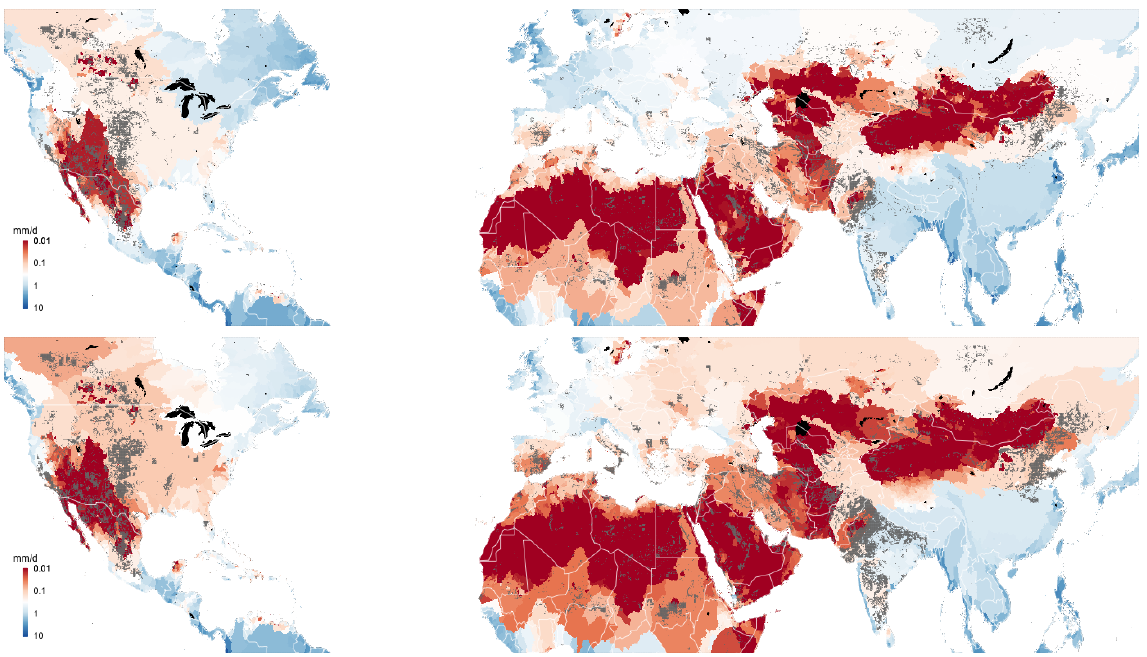
Figure 9. Global limits to stable groundwater withdrawal rate. Top: limit to physically stable groundwater withdrawal mapped as the median q crit per sub-basin (based on HydroBasins: Lehner et al., 2008); grey-shaded areas are those for which q > q crit ; bottom: limit to ecologically stable groundwater withdrawal mapped as the median q eco per sub-basin; grey-shaded areas are those for which q > q eco